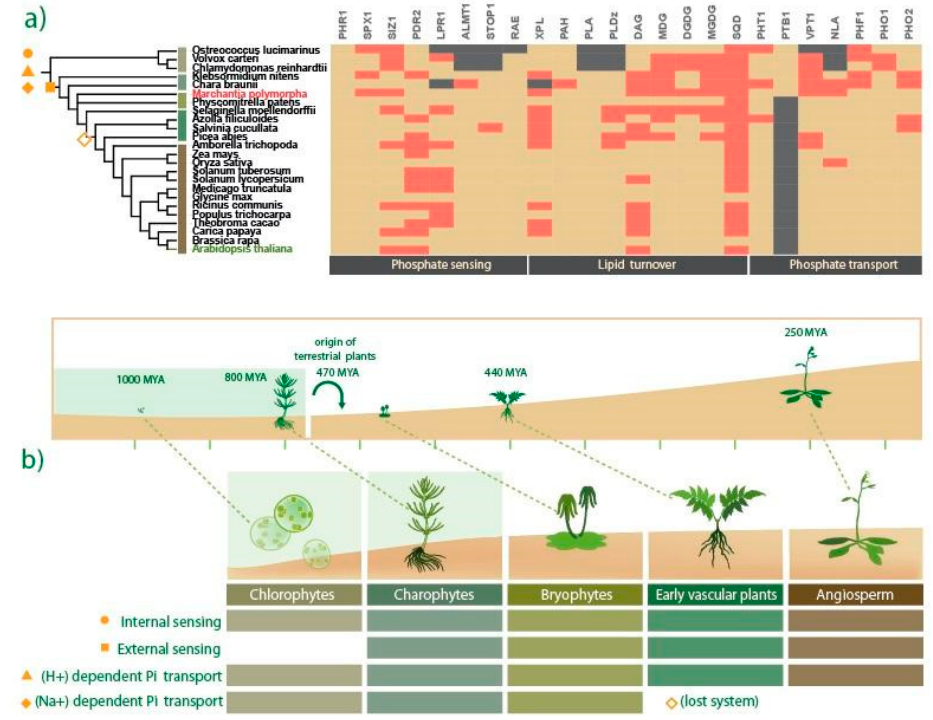
Figure 1. Evolution of phosphate starvation responses in land plants. ( a ) Phylogenetic tree containing 24 representative genomes sampled across plant kingdom, the cladogram was taken from the NCBI taxonomy browser (https://www.ncbi.nlm.nih.gov/Taxonomy/CommonTree/wwwcmt.cgi). The heatmap shows a comparative conservation analysis of key genes involved in Pi sensing, lipid turnover, and Pi transport. Red-colored rectangles represent single copy genes, beige-colored rectangles mean that for such proteins there are two or more genes, and gray-colored means that no gene coding for such proteins was identified through our approach (see methods for details). Figures S2–S24 show the phylogenetic reconstruction for each gene analyzed. ( b ) Land plant evolution timeline. A close-up highlight of the morphological differences between chlorophytes, charophytes, bryophytes, gymnosperms, and angiosperms. Color rectangles showed the conservation for key mechanisms to cope with Pi starvation, such as an internal sensing network, external sensing network, (Na + ) and (H + ) dependent Pi transporters.